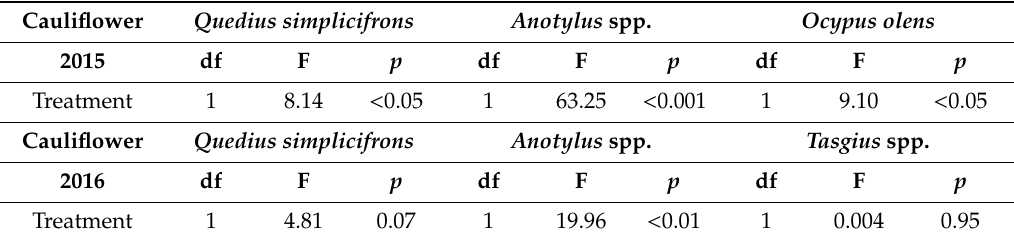
Table 3. Results of ANOVA carried out on the most abundant species of Staphylinidae (pooling all the individuals caught in each plot over the whole sampling period) in cauliflower plots.